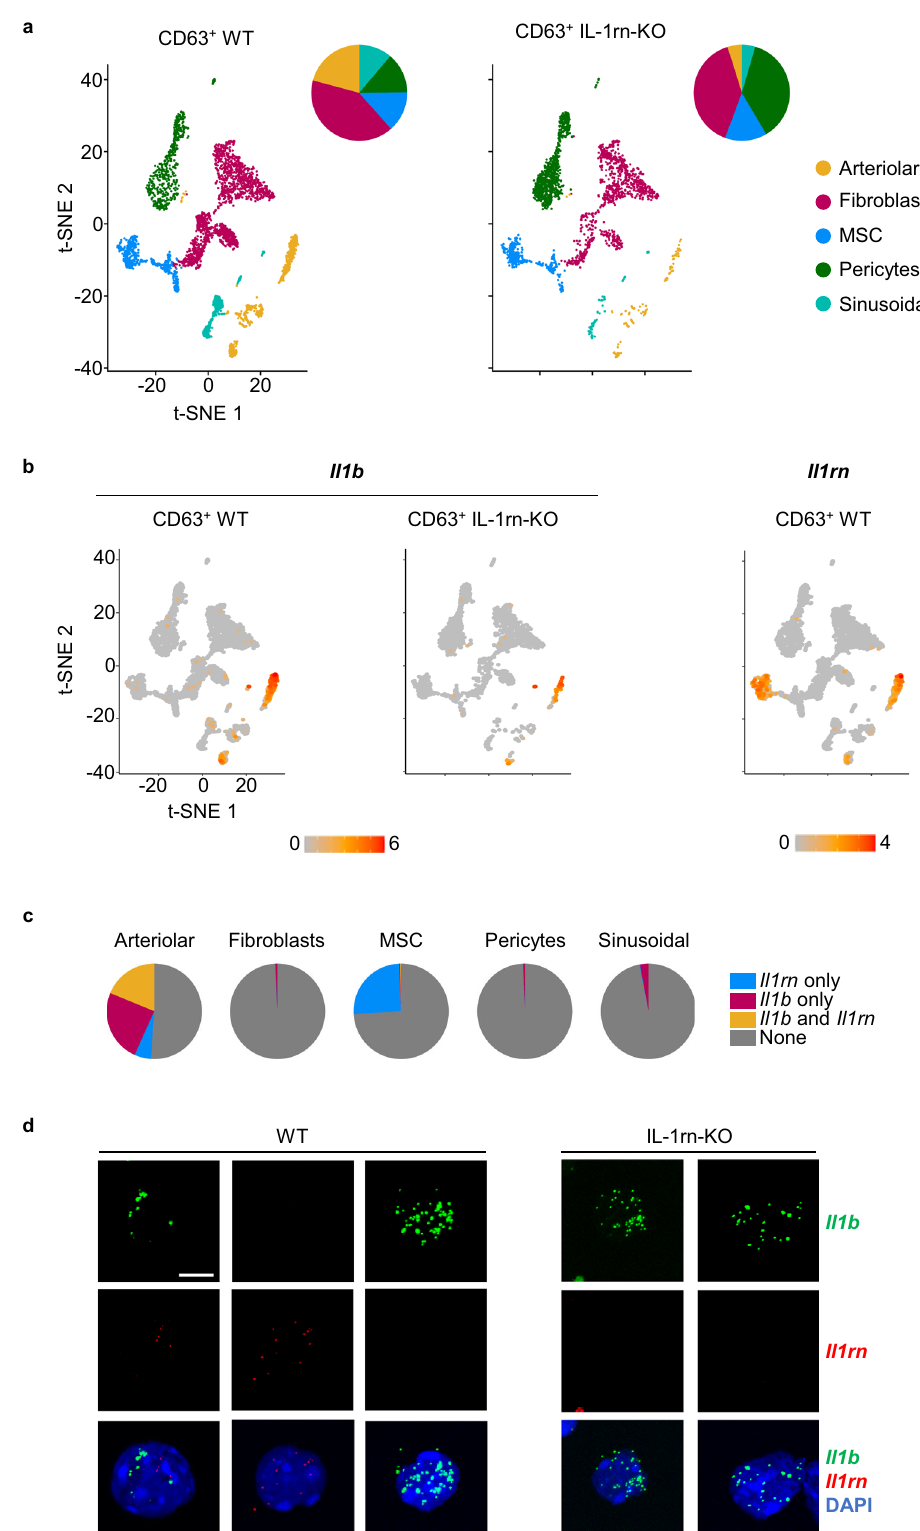
Fig. 7 | Identi fi cation of the sources of IL-1 β and IL-1rn in the bone marrow at thesingle-celllevelwithintheCD63 + stromalcellcompartment. a,b Single-cell RNA sequencing in bone marrow (BM) BM CD45 - CD31 - Ter119 - CD63 + stromal cells from C57BL/6J wild-type (WT, n =1 sample from 2 biologically independent ani- mals) and IL-1rnknockout (IL-1rn-KO, n =1 sample from 2 biologicallyindependent animals) mice. a t-SNE plots visualizing colored cluster assignment annotated with GSE128423 dataset using the maximum enrichment score ±0.2 and subsequent manual curation. Pie charts with cluster distribution are shown to the right of the